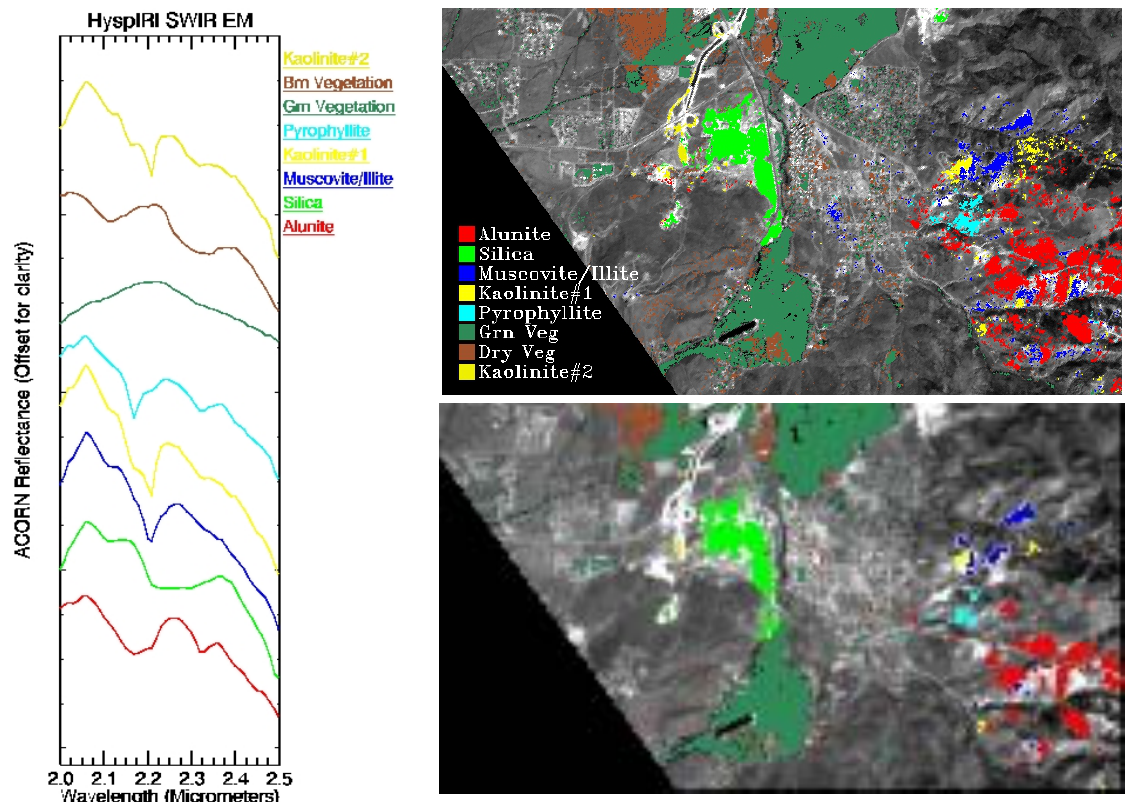
Figure 4. Left: SWIR mineral endmember spectra extracted from the 15 m spatial resolution, HyspIRI-simulated imaging spectrometer data. Right: Comparison of SWIR mineral mapping using 15 m simulated HyspIRI data (Top) and 60 m simulated HyspIRI data